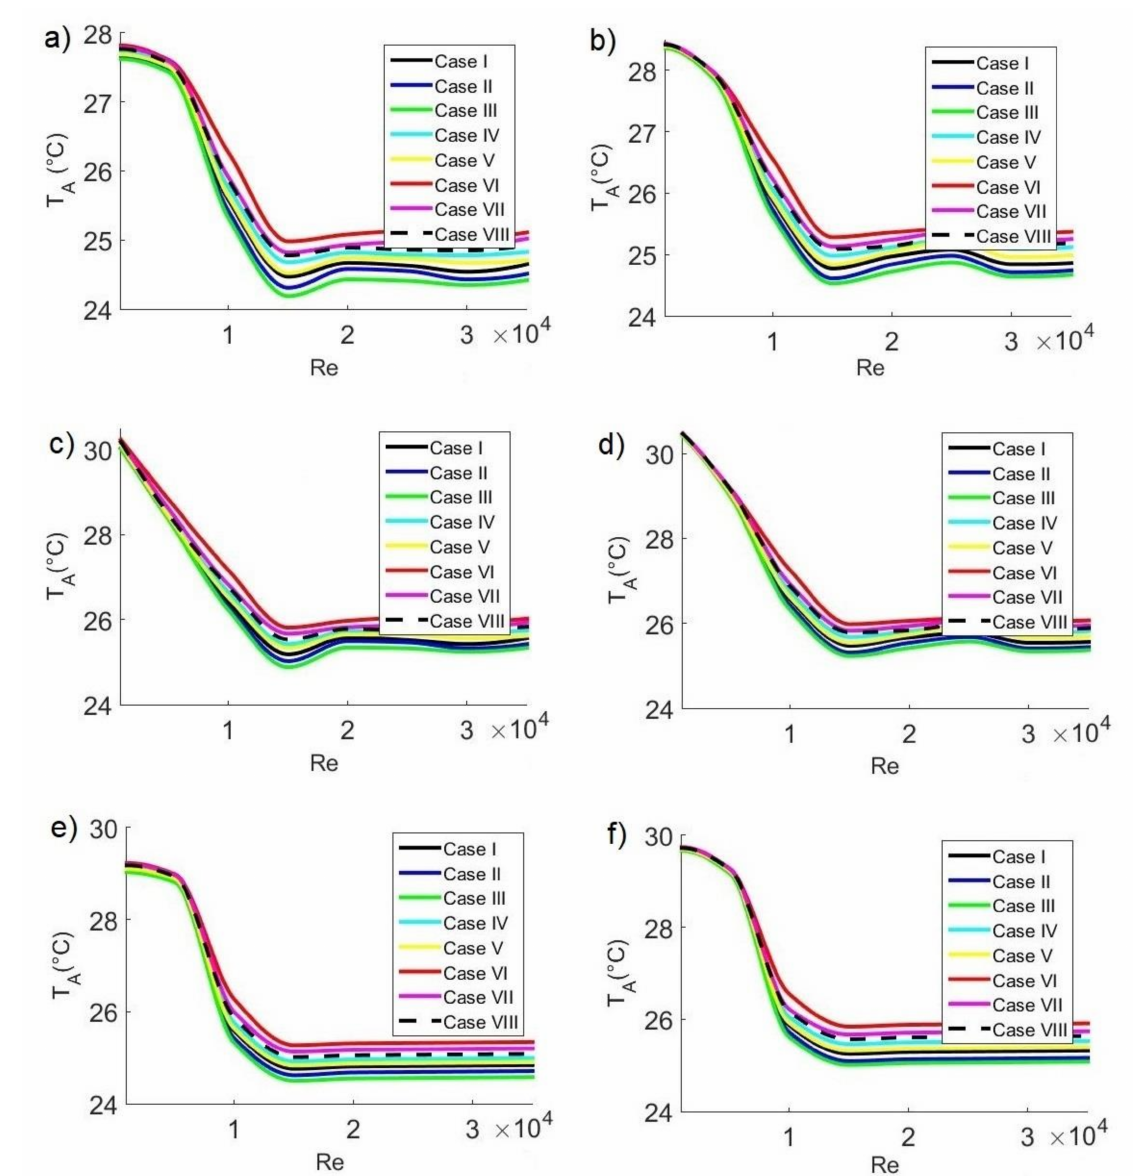
Figure 8. Average air temperature in the classroom as a function of Reynolds number at 11:30 a.m. with CO 2 sources of ( a ) 35,000 ppm and ( b ) 42,500 ppm; at 3:30 p.m. with CO 2 sources of ( c ) 35,000 ppm and ( d ) 42,500 ppm; and at 6:30 p.m. with CO 2 sources of ( e ) 35,000 ppm and ( f ) 42,500